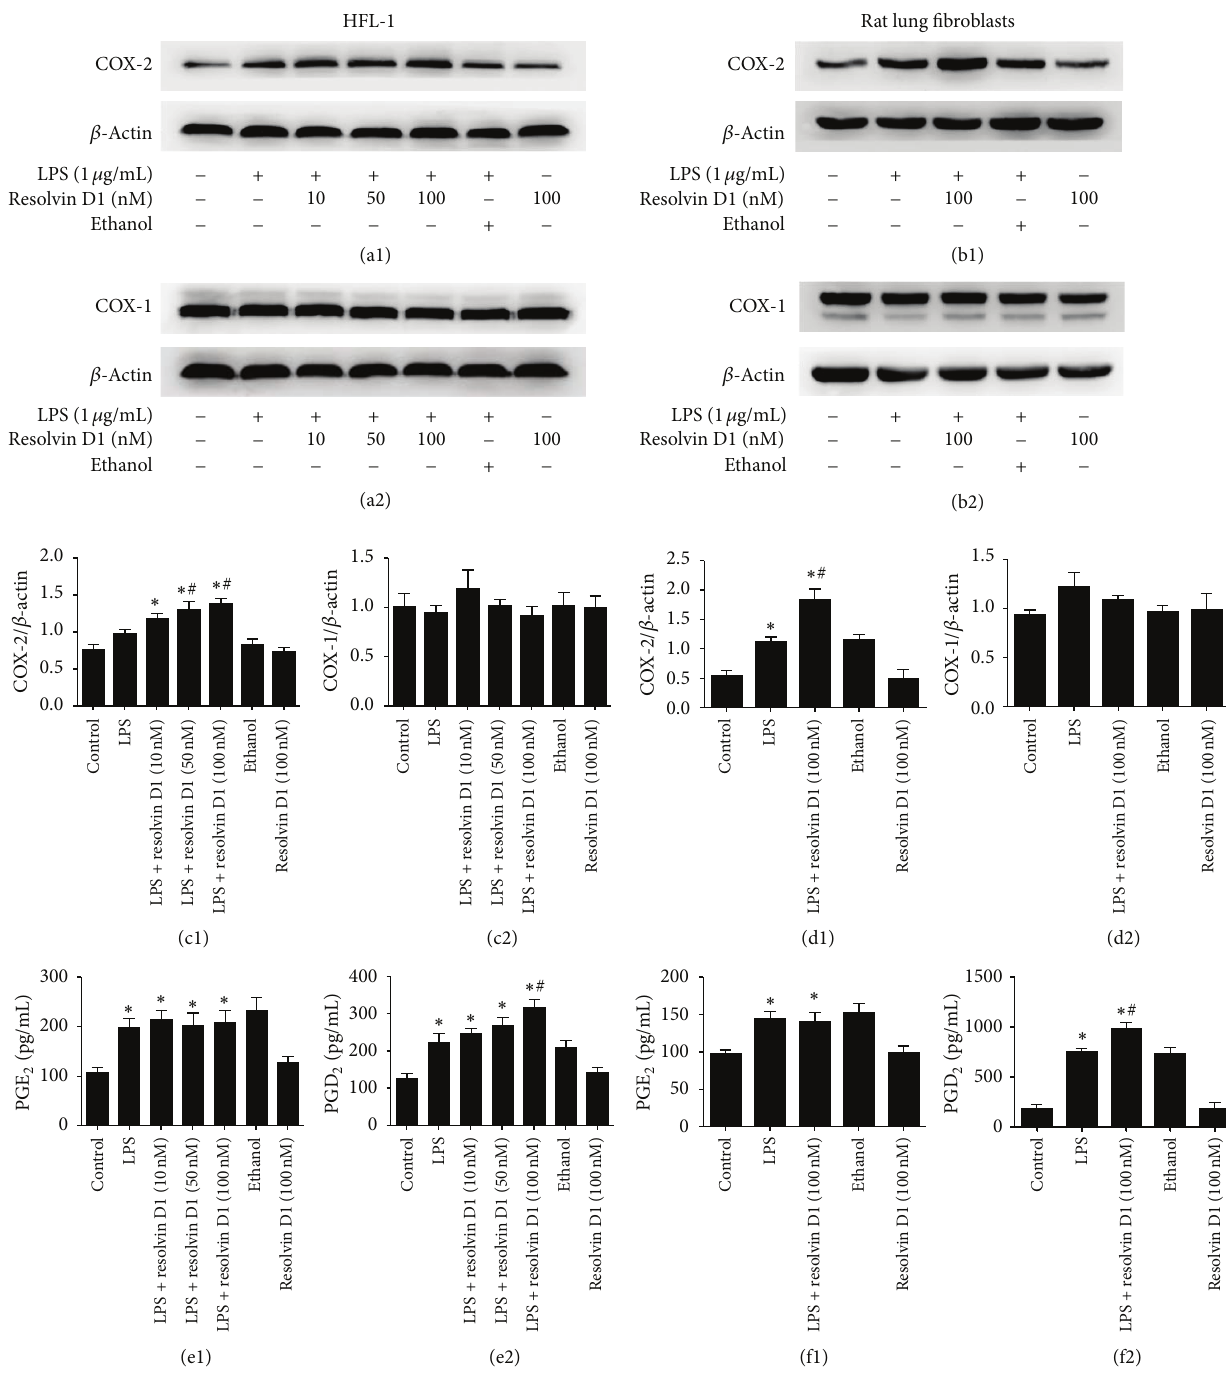
Figure3:TheEffectofresolvinD1onexpressionofCOXs(COX-1andCOX-2)andPGE 2 andPGD 2 productionat48hoursinlungfibroblasts stimulated with LPS. ((a1), (a2), (c1), (c2)) HFL-1 cells were incubated with LPS after 48 hours in the presence or absence of 10, 50, or 100nM of resolvin D1. COX-2 protein was detected by western blot ( ∗ 𝑃 < 0.05 versus control, # 𝑃 < 0.05 versus LPS, LPS + resolvin D1 (10nM) groups). No significant change in the protein expression of COX-1 was observed after treatment with LPS in HFL-1 cells. ((e1), (e2)) Supernatants from HFL-1 cells treated with resolvin D1 at 0, 10, 50, or 100 nM in the presence of LPS (1 𝜇 g/mL) for 48 hours were collected and PGE 2 protein was measured by ELISA. Data are expressed as mean ± SE for each group (e1) ( ∗ 𝑃 < 0.05 versus control). PGD 2 protein was measured by ELISA. Data are expressed as mean ± SE for each group (e2) ( ∗ 𝑃 < 0.05 versus control, # 𝑃 < 0.05 versus LPS group). ((b1), (b2), (d1), (d2), (f1), (f2)) We also dulicated our test in primary rat lung fibroblasts. (d1) ( ∗ 𝑃 < 0.05 versus control, # 𝑃 < 0.05 versus LPS group). (d2) There was no significant change in COX-1 expression after LPS treatment in primary rat lung fibroblasts. ( ∗ 𝑃 < 0.05 versus control, (f1)). ( ∗ 𝑃 < 0.05 versus control, # 𝑃 < 0.05 versus LPS group, (f2)). All experiments were repeated in